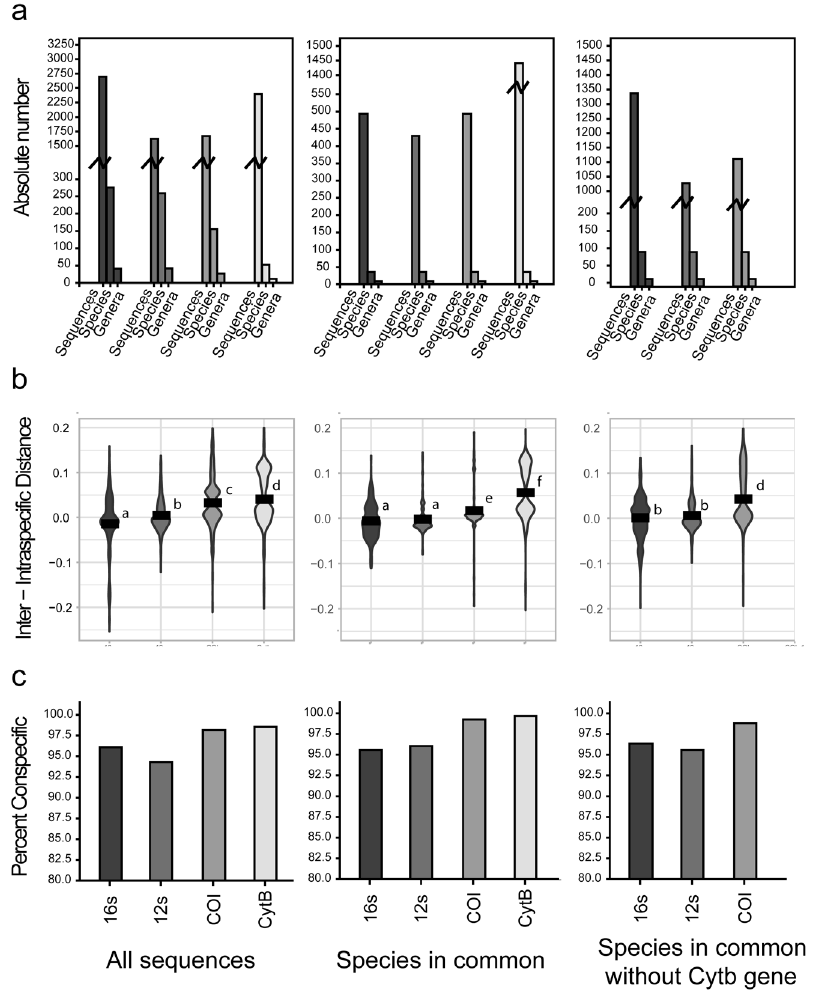
Distance-based evaluations